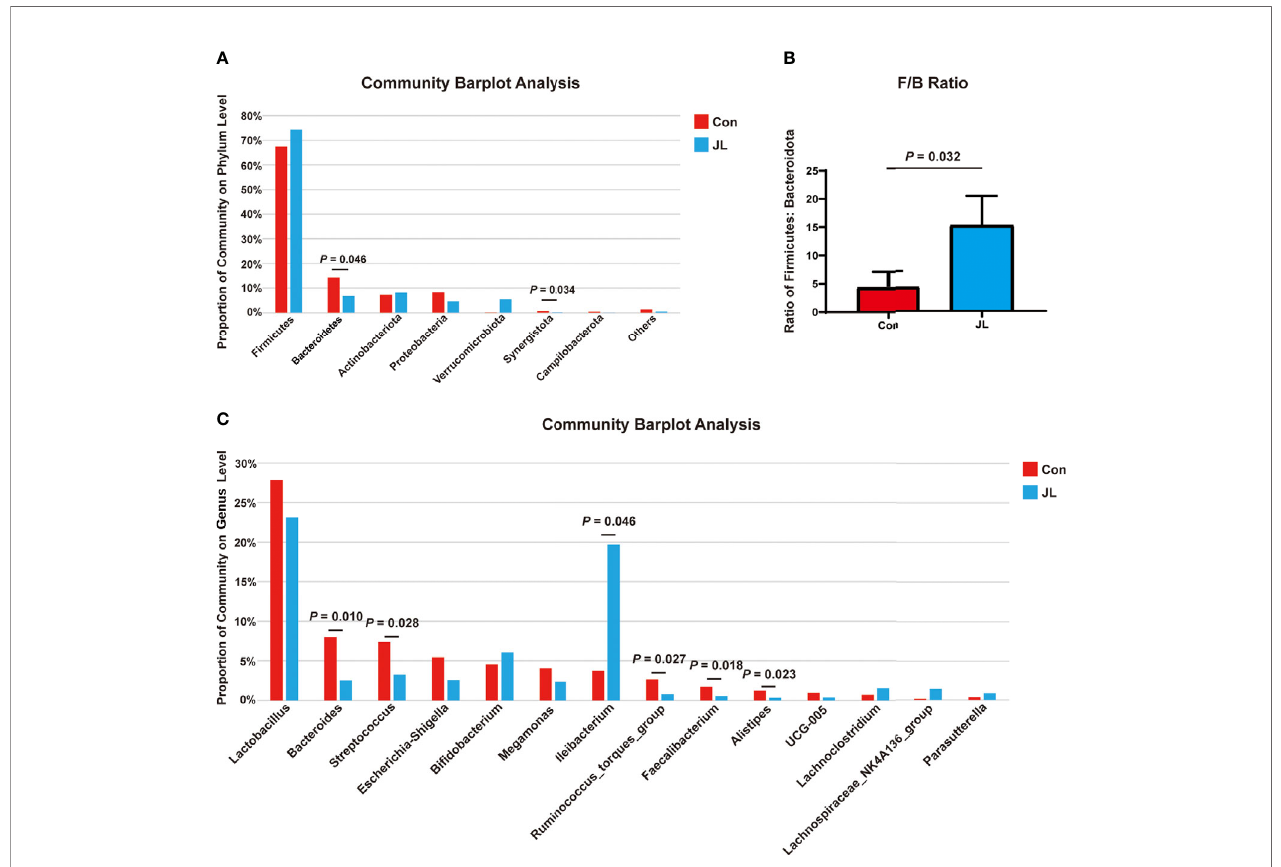
FIGURE 5 | The differences of jejunal microbiota between Con (n = 6) and JL (n = 5) groups. (A) Community barplot on phylum level of each group in jejunum. (B) Ratio of Firmicutes to Bacteroidota. (C) Proportion of top 15 bacteria on genus level of Con and JL groups. Differences were assessed by student ’ s t